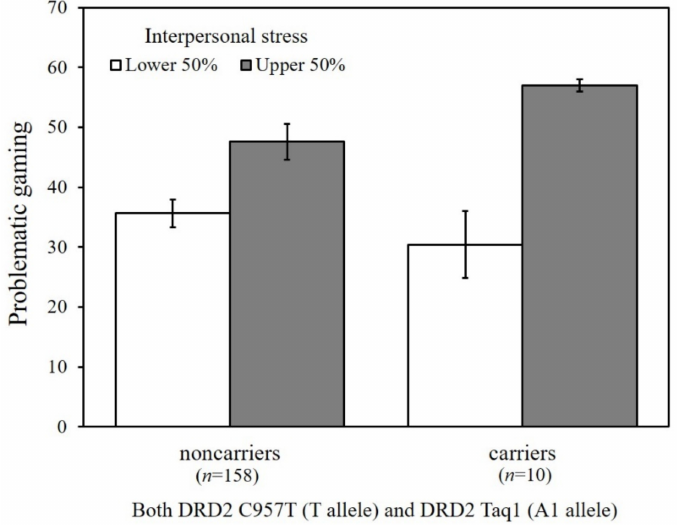
Figure 4. Estimated means of problematic gaming as a function of the DRD2 C957T and Taq1 allele types and levels of interpersonal stress. Vertical bars represent the standard error below and above the mean